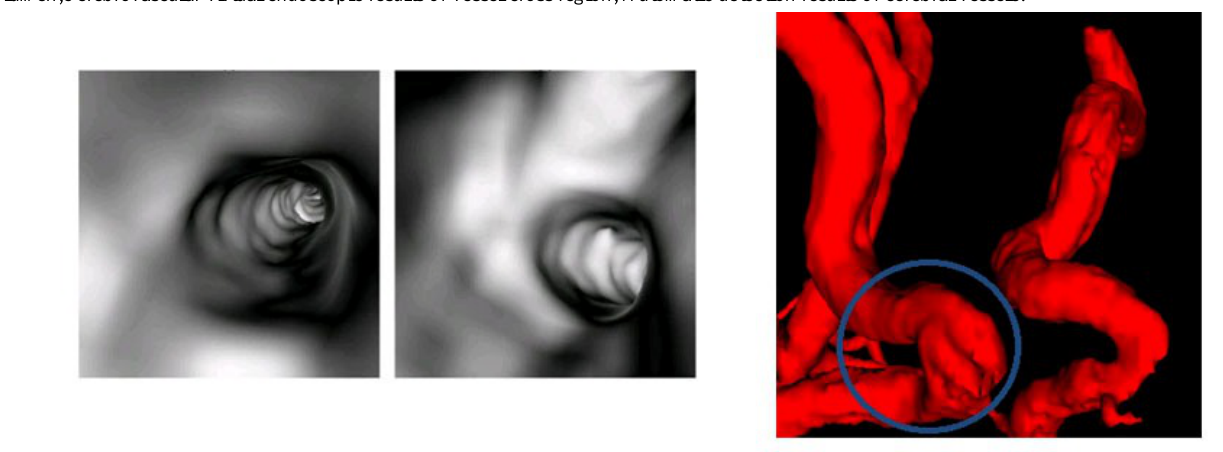
Figure 12. The virtual endoscope and automatic detection result. From left to right: Cerebrovascular virtual endoscopic results of the lumen;Cerebrovascular virtual endoscopic results of vessel cross region; Automatic detection results of cerebral